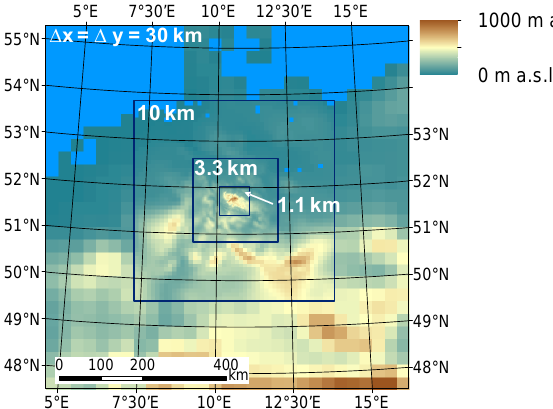
Figure 2. WRF domains of the study area. The resolution of the first (outer) domain is 30km, the fourth and final (inner) domain’s resolution is